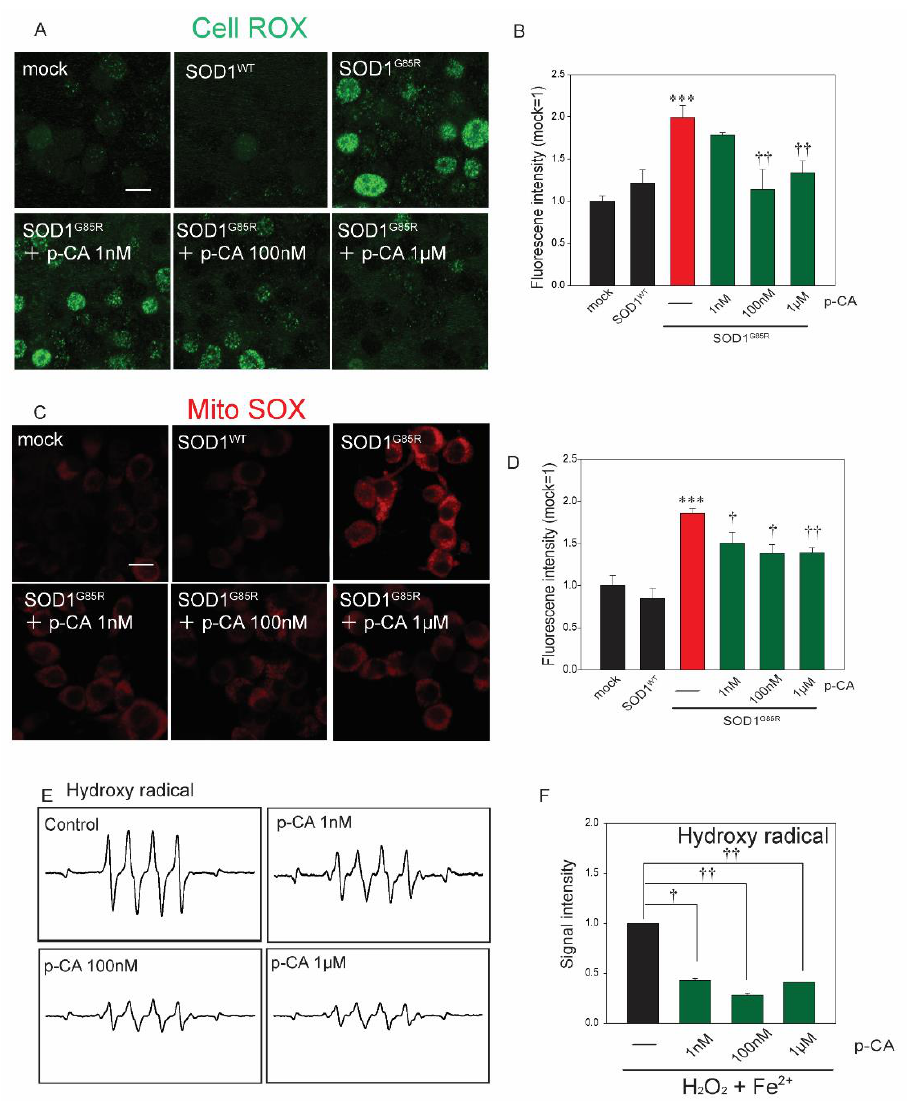
Figure 2. p-CA reduced mutant-SOD1-related oxidative stress. ( A ) Confocal imaging of CellROX in N2a cells transfected with mCherry–SOD1 G85R with p-CA for 24 h. ( B ) Quantified analysis of CellROX using Image J. ( C ) Confocal imaging of MitoSOX in N2a cells transfected with mCherry–SOD1 G85R with p-CA for 24 h. ( D ) Quantified analysis of MitoSOX using Image J. ( E ) Typical spectra of DMPO-OH spin generated from H 2 O 2 plus Fe 2 + in the absence (control) or presence of p-CA. ( F ) The amount of hydroxy radicals was semi-quantitatively measured as the formation of DMPO-OH spin adducts by ESR spectrometry. Di ff erences were evaluated by one-way ANOVA (mean ± SEM, n = 3). *** p < 0.001 vs. SOD1 WT , †† p < 0.01, † p < 0.05 vs. SOD1 G85R . Scale bar: 10 µ m. p-CA: p-coumaric acid.